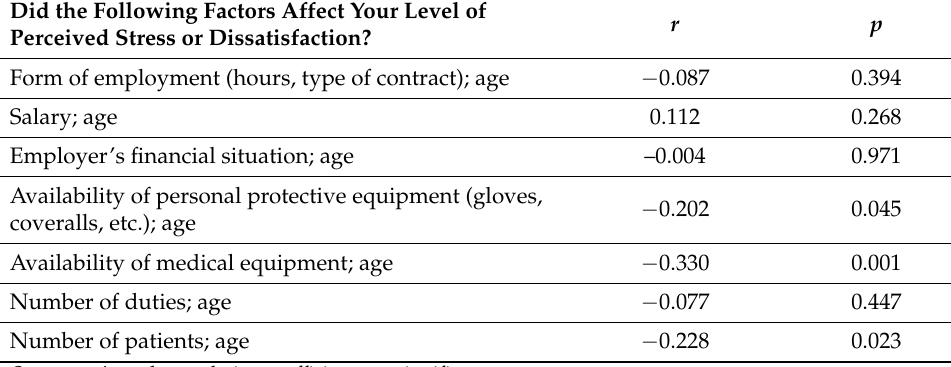
Table 6. Factors affecting stress according to age.